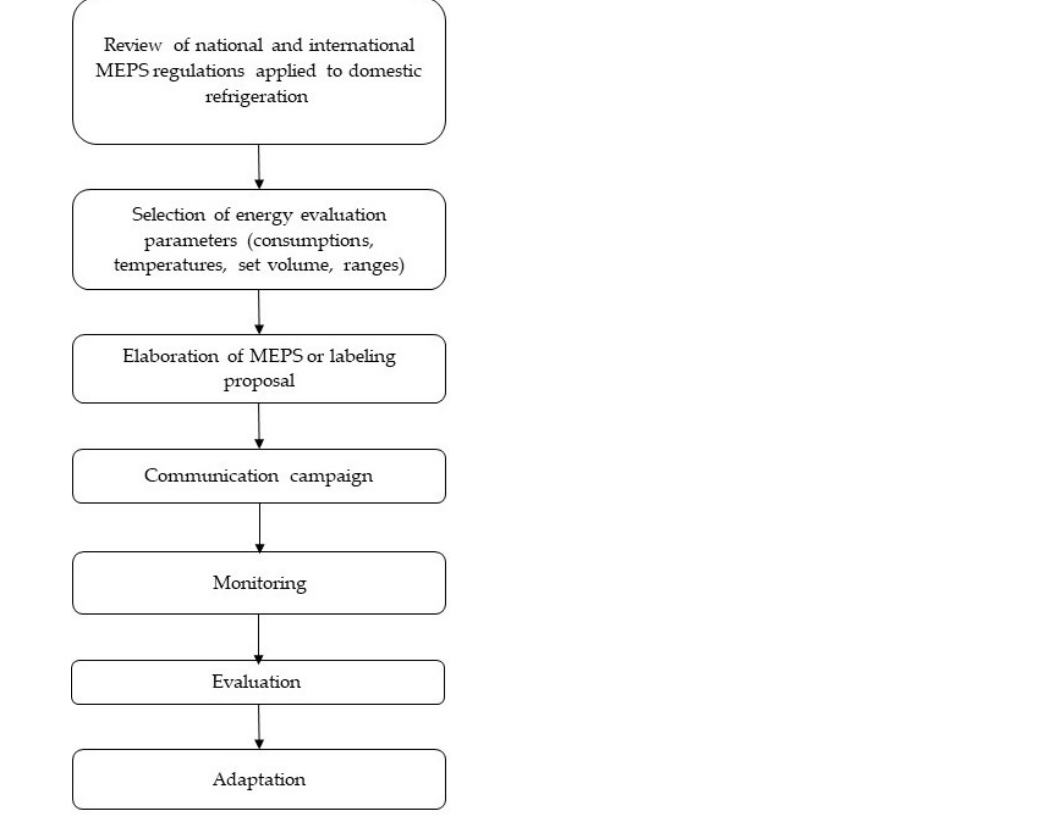
Figure 11. Proposed Road-map for the implementation of MEPS in residential refrigeration in Colombia.